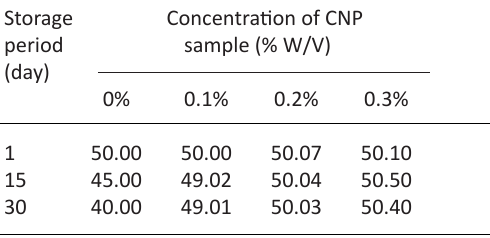
Table 3. Changes in rancidity of pasteurized milk with chitosan nanoparticals (CNP) at different concentrations (0.1, 0.2 and 0.3% w/v) and without CNP during (1, 15 and 30) days of storage at